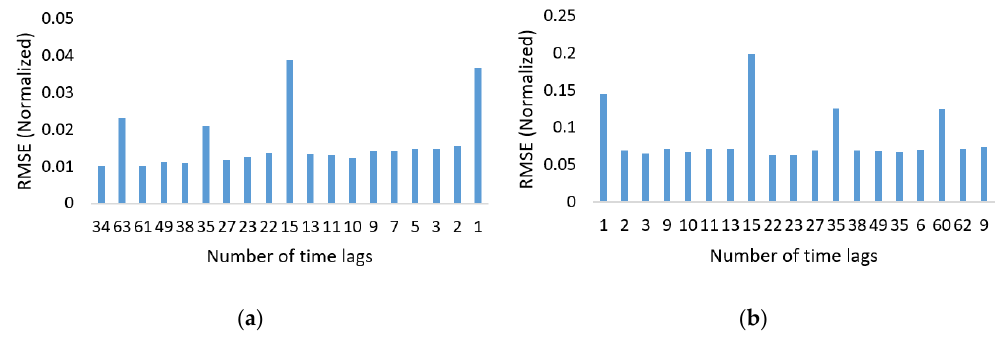
Figure 11 . Root mean square error (RMSE) vs. time lags for ( a ) six and ( b ) four hidden layers.